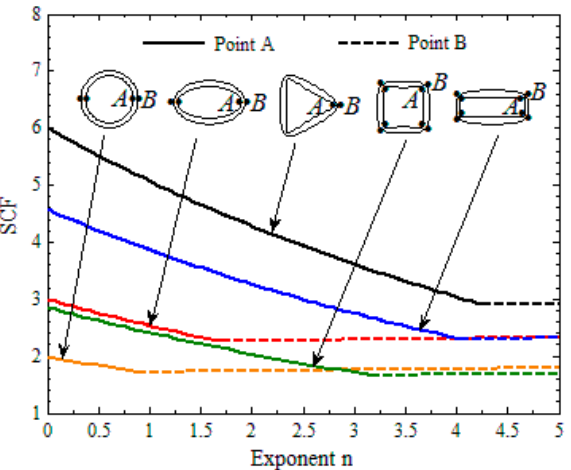
Figure 13. The variation in SCF with exponent n for different shaped holes.